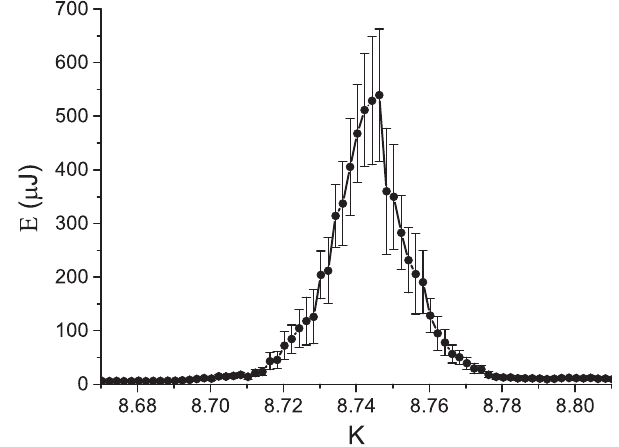
FIG. 2. Scan of the K value of the first part of the undulator consisting of five undulator segments, tuned to 700 eV. Mean pulse energy and its standard deviation are measured after the second part of the undulator tuned to 2.1 keV. FEL operates in “ 5 þ 7 segments HLSS ”